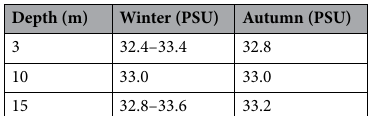
Table 2. Salinity versus depth at Region 4 of Tokyo Bay in Winter and Autumn 34